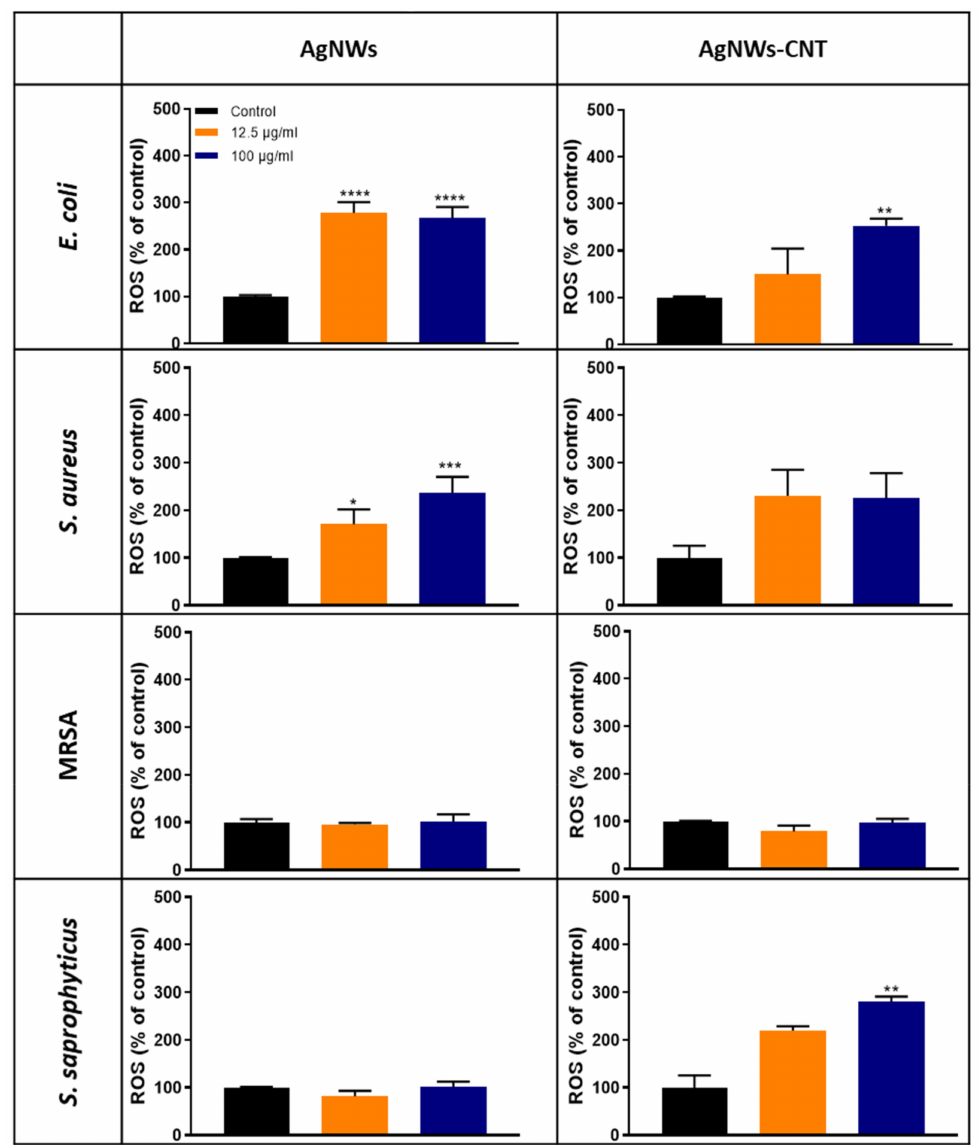
Figure 5. ROS production (% of the control) from bacterial cells, 24 h from treatment. E. coli ( A , B ), S. aureus ( C , D ), MRSA ( E , F ) and S. saprophyticus ( G , H ) treated with 12.5 and 100 µ g / mL of AgNWs or AgNWs-CNT. Data are presented as the mean ± SD ( n = 3). The one-way ANOVA performed on all the samples showed significantly di ff erent ROS production for both AgNWs and AgNWs-CNT ( p < 0.05) for some of the bacterial strains. Results of the post-hoc Tukey multicomparison test are shown in the graphs (* indicates p < 0.05, ** indicates p < 0.01, *** indicates p < 0.001 and **** indicates p <